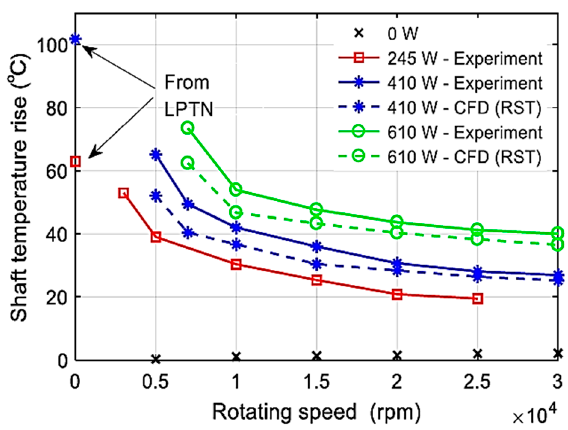
Figure 18. Variation in temperature with different speeds as regards iron loss [83].